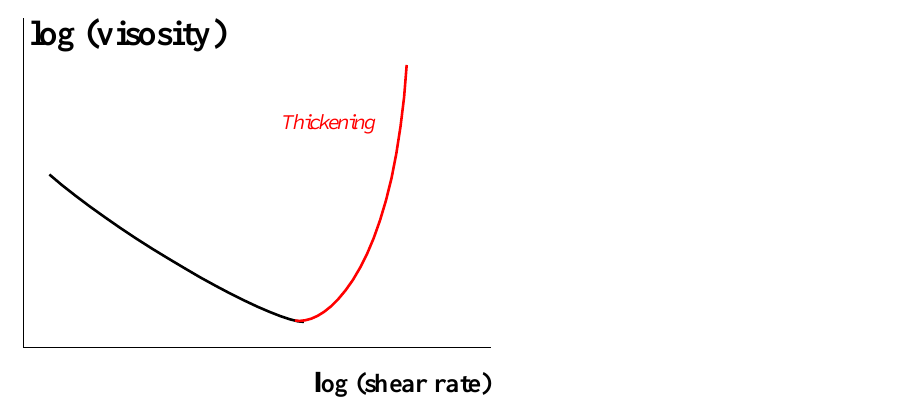
Figure 23. Transition from the viscosity decreasing at low shear rates to the thickening and jamming at high ones.